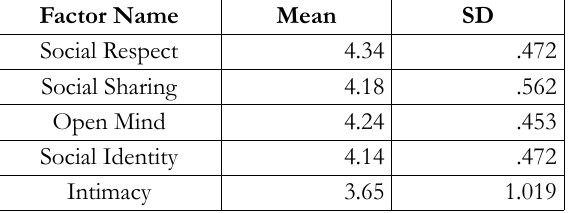
Table 1. Students’ perception of their social presence on Web